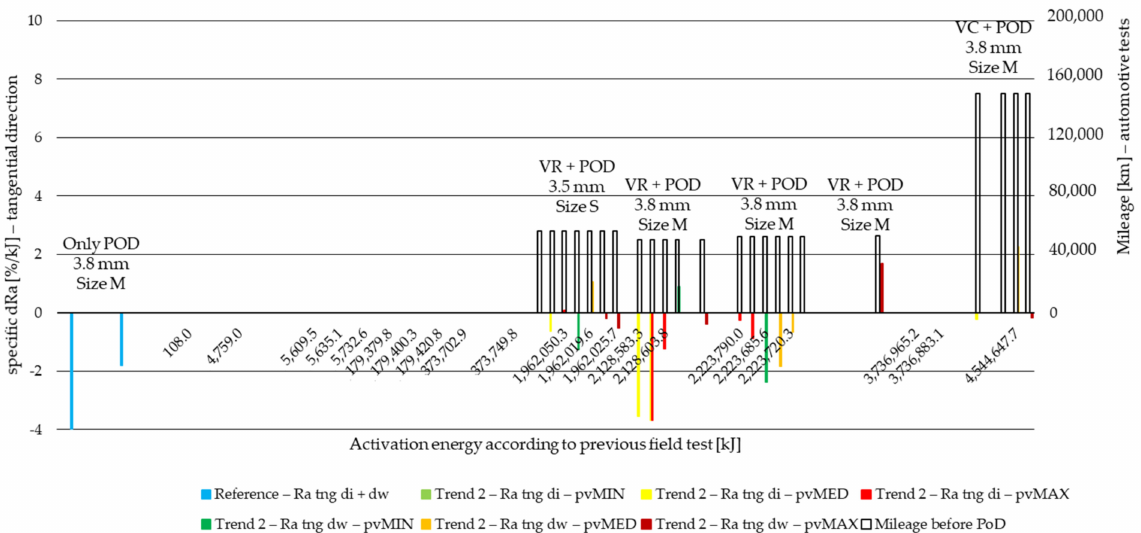
Figure 17. Tangential direction PoD specific Ra difference values of cut material samples from inner and working diameter after minimum, medium and maximum pv level pin-on-disc tests with previous field-test (Table 2) mileage along Joule scale—Trend 2: moderate load cases: VR, VC. Examining radial direction Ra delta values, the following can be